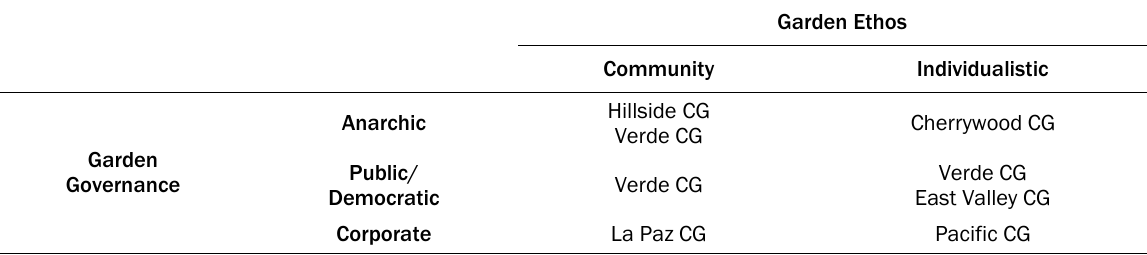
Table 4. Garden Governance and Ethos for Six SOC